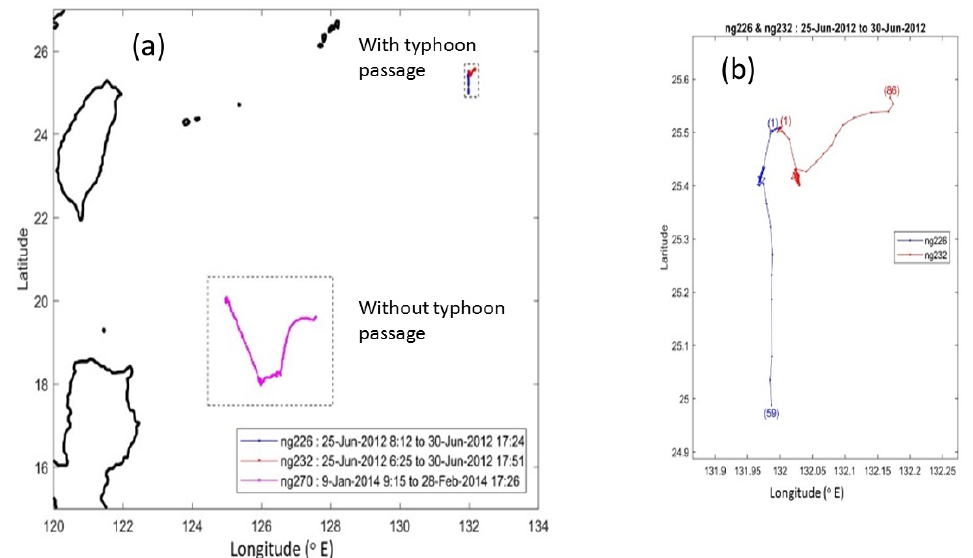
Figure 2. Tracks of ( a ) Naval Oceanographic Office (NAVOCEANO) Seagliders NG270 from January 9 to February 28, 2014 (red) without typhoon activity, as well as a zoomed-in view of tracks of the Seagliders (NG226, NG232) from January 25 to January 30, 2012 (blue) after Super Typhoon Guchol‘s passage, and ( b ) a zoomed-in view of NG226 and NG232.